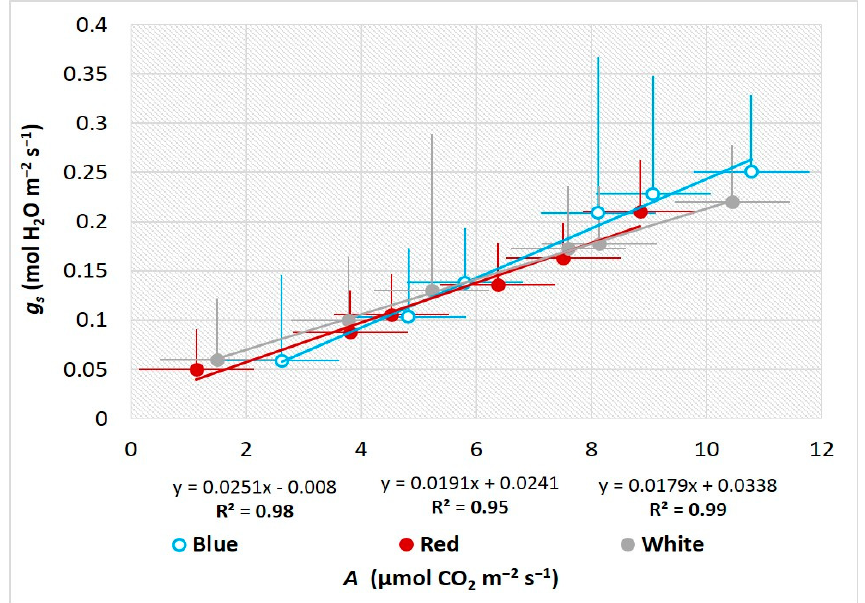
Figure 3. Correlation between photosynthetic rate ( A ) and stomatal conductance ( g s ) in Eustoma leaves under blue, red, and white LEDs at different PPFDs. Data are mean values ( n = 10); the vertical and horizontal bars represent ± SE. All R 2 values are statistically significant at P < 0.01.